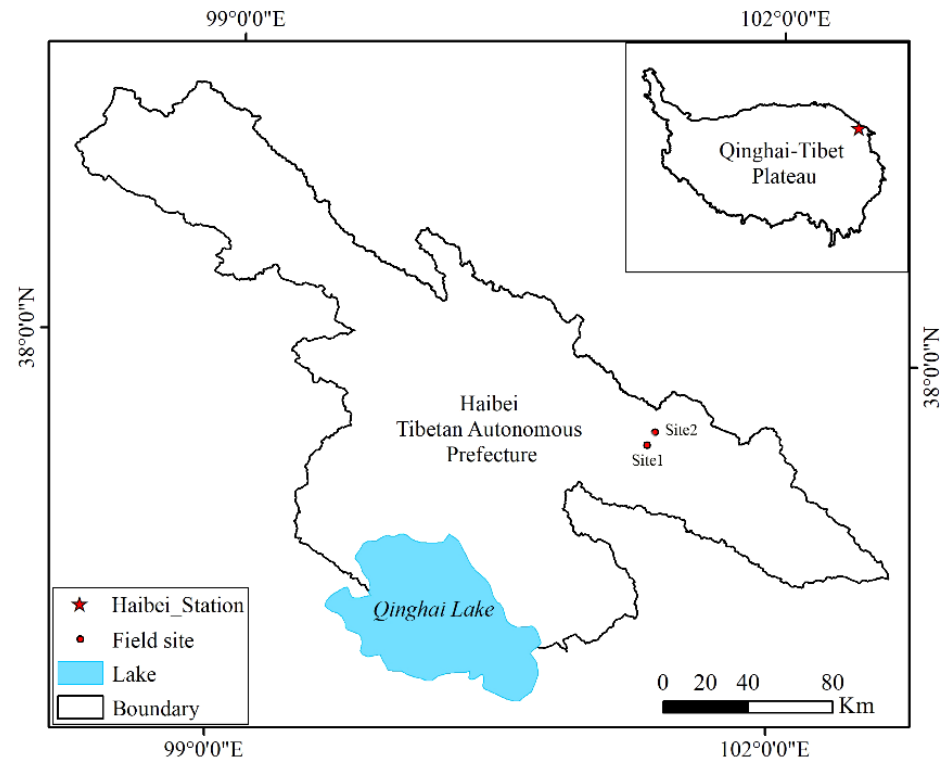
Figure 1. The location of study area. Site 1 was the location of the degraded shrub, while site 2 was the location of the non-degraded shrub. Table 1. The basic information of alpine shrub meadow in this